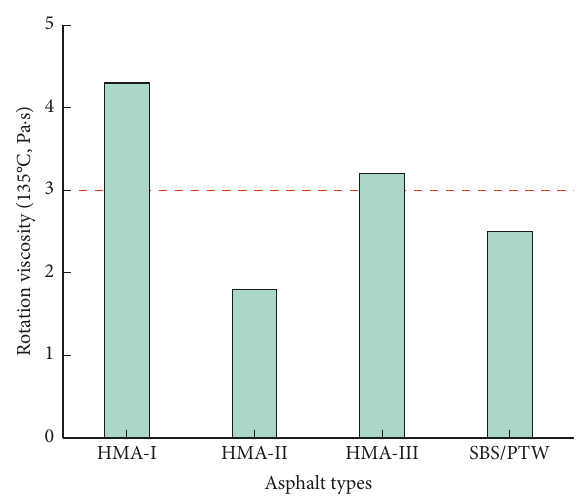
Figure 5: Viscosity of different modified asphalt at 135 °